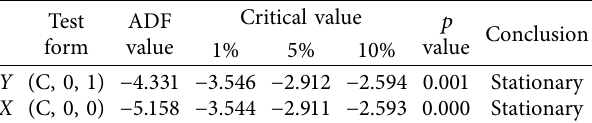
Table 2: Results of the unit root test.